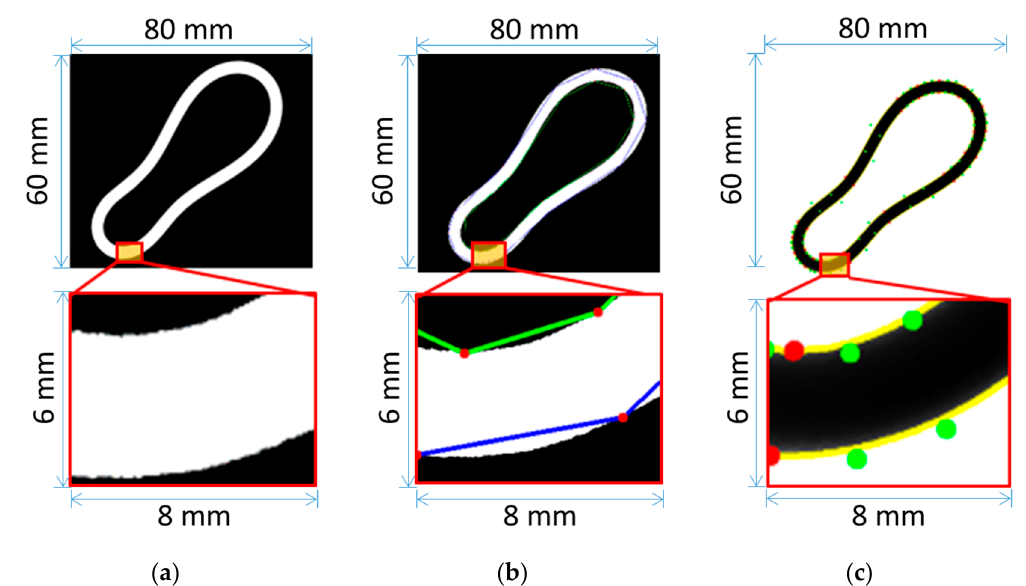
Figure 27. ( a ) Schematic diagram of the edge of contour with noise and protrusions; ( b ) Schematic diagram of approximate points with loss information by Ramer–Douglas–Peucker algorithm in large threshold. The red points are the algorithm result points, and the green and blue lines represent internal edge-tracking result and external edge tracking result; ( c ) Schematic diagram of fitting results found using cubic Bézier curves. which green points are cubic Bézier control points p 01 and p 02 by Equation (19). The yellow curve was the fitting result of our cubic Bézier fitting algorithm.